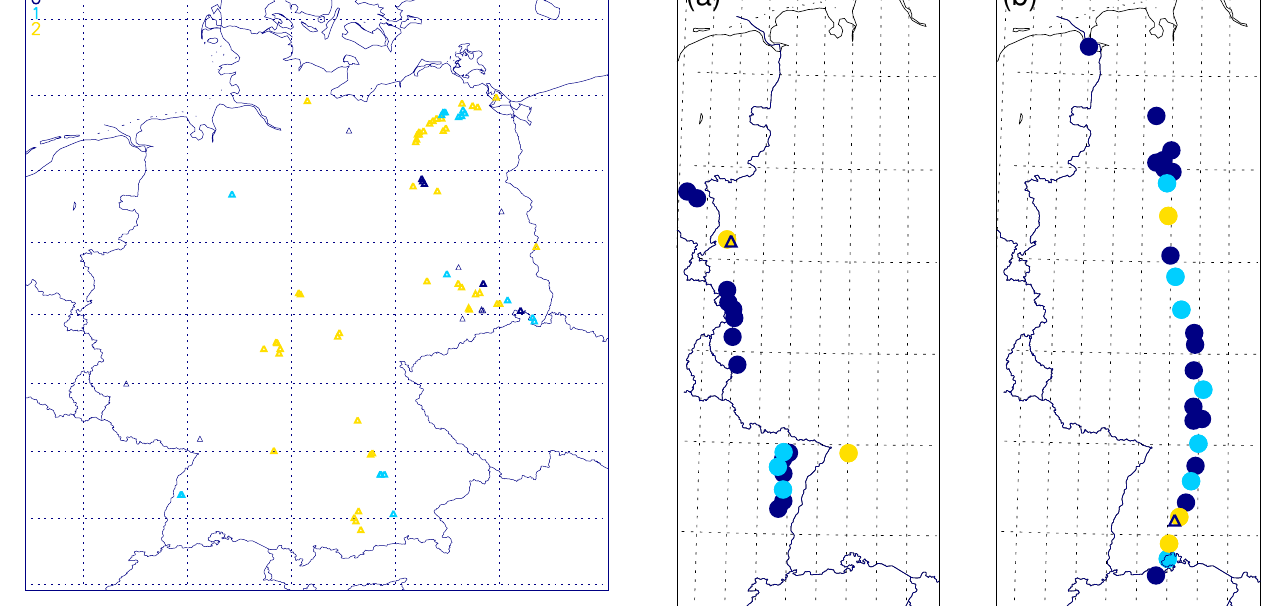
Figure 6. KONRAD hailflag (dark blue, light blue and yellow circles) and QC0 eswd hail reports (triangles) within ± 5min of 14 July 2010, 16:15UTC (a) and 18:45UTC (b)